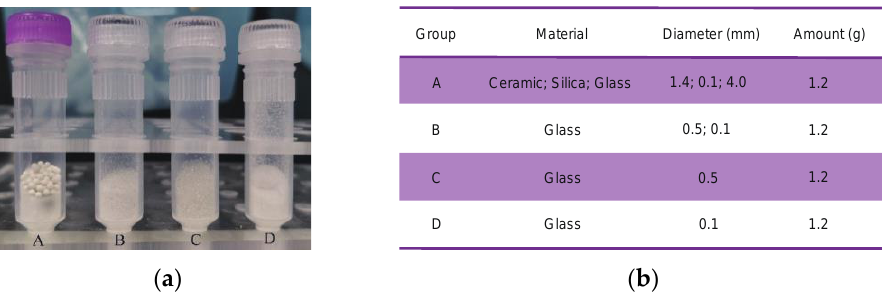
Figure 2. ( a ) Four combinations of grinding beads. ( b ) Specific parameters for each combination of grinding beads.